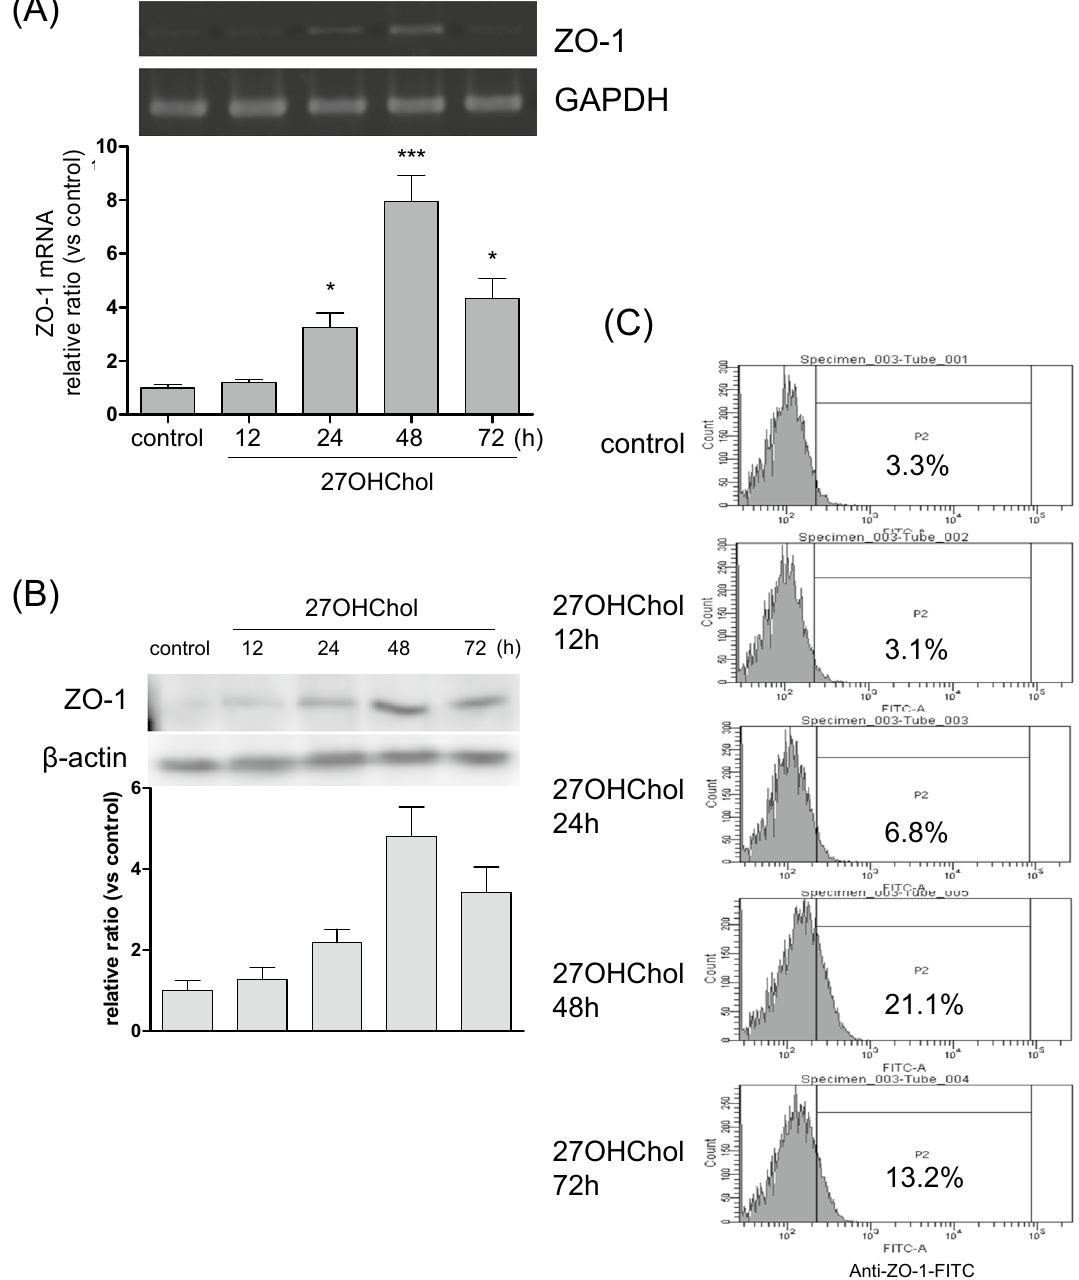
Figure 3. Time-course analyses of the ZO-1 expression following treatment with 27OHChol. THP-1 monocytic cells were stimulated for the indicated durations of time with 2.5 µg/ml of 27OHChol. ( A ) The ZO-1 transcript levels were analyzed using RT-PCR and real-time PCR. The data are expressed as the mean ± SD (n = 3 replicates/group). *** P < 0.01 versus control; * P < 0.1 versus control. ( B ) The ZO-1 protein was detected via Western blot analysis using cell lysates. ( C ) The cells were immunostained with antibodies against ZO-1 and analyzed by flow cytometry. The results are representative of three independent